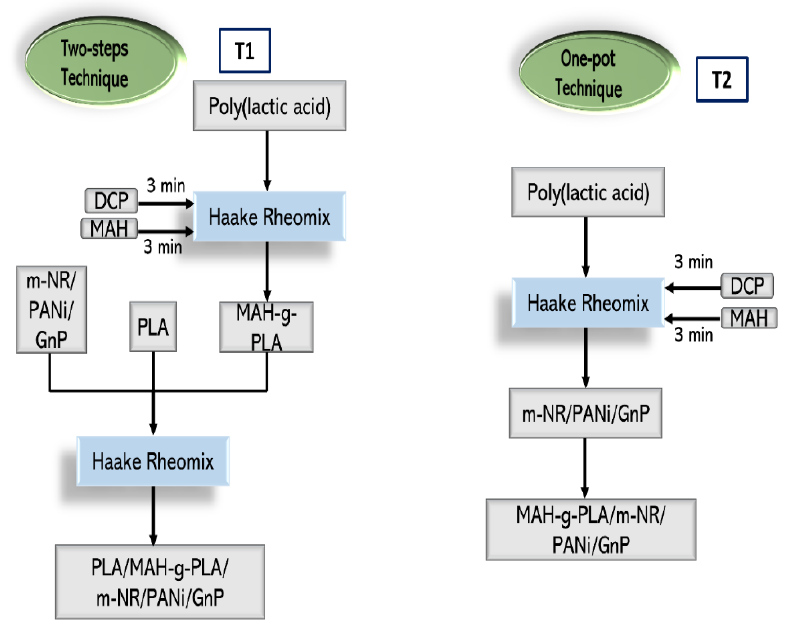
Figure 1. Preparation flow of PLA/MAH-g-PLA/m-NR/PANi/GnP and PLA/MAH/DCP/m- NR/PANi/GnP nanocomposites.